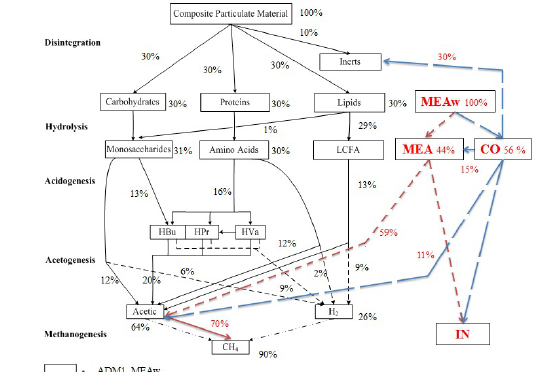
Figure 1: COD flux for the original ADM1 (black line) and the expanded ADM1 MEAw (color dashed lines). HBu - Butyric acid, HPr Pro- pionic acid, HVa Valeric acid, LCPA - long chain fatty acid, MEA monoethanolamine, MEAw monoethanolamine waste, CO com- plex organics, IN inorganic